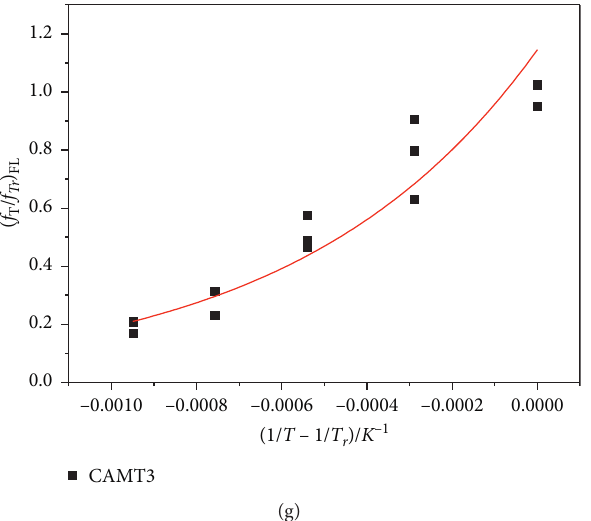
Figure 3: Relationship between ( f (f) CAMT2, and (g) CAMT3.